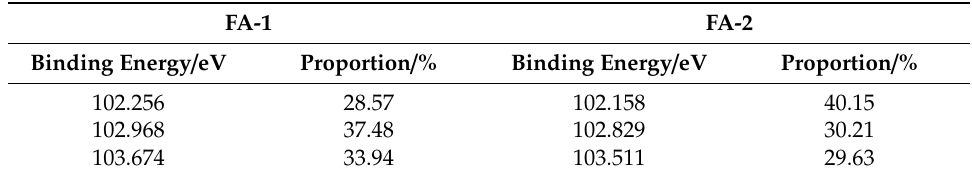
Figure 11. Si 2p X-ray photoelectron spectra (XPS) for FA-1 and FA-2. Table 6. Fitting results of the Si 2p XPS spectra.